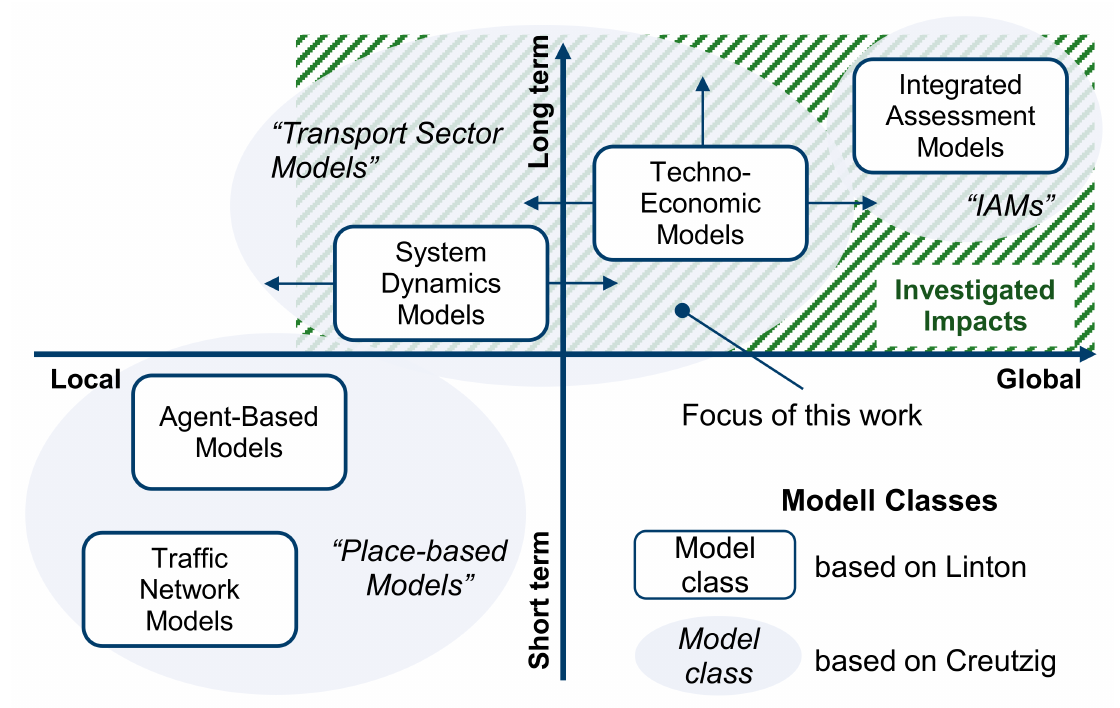
Figure 2. Model classification of different techniques to calculate GHG emissions from transport based on Linton [4] and Creutzig [5].